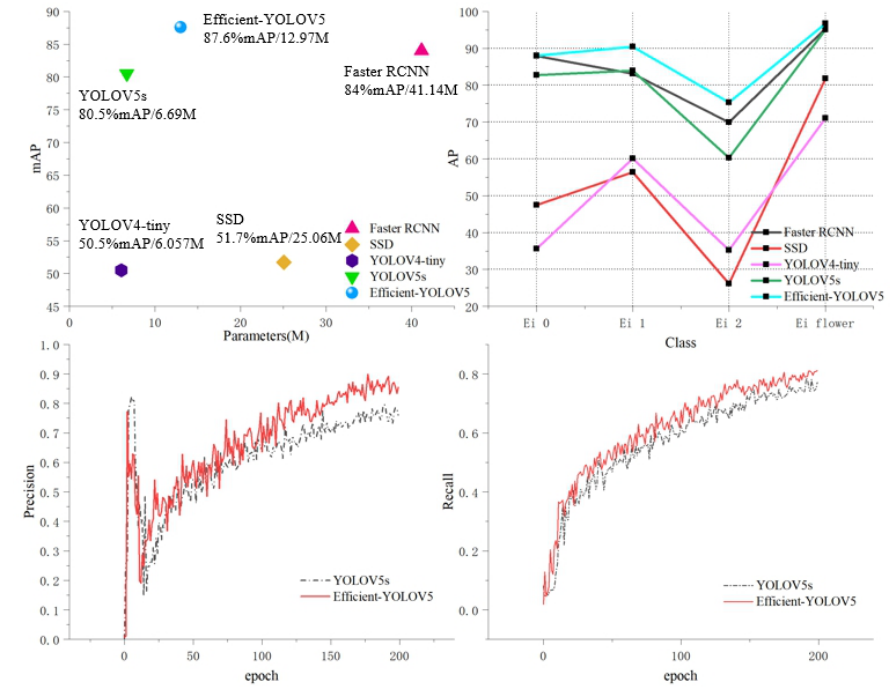
Figure 11. Comparison of efficient YOLOV5 with other algorithms. The comparison experiment was performed under the framework of YOLOV5, in order to compare the various backbone networks and neck networks, as well as to add different modules